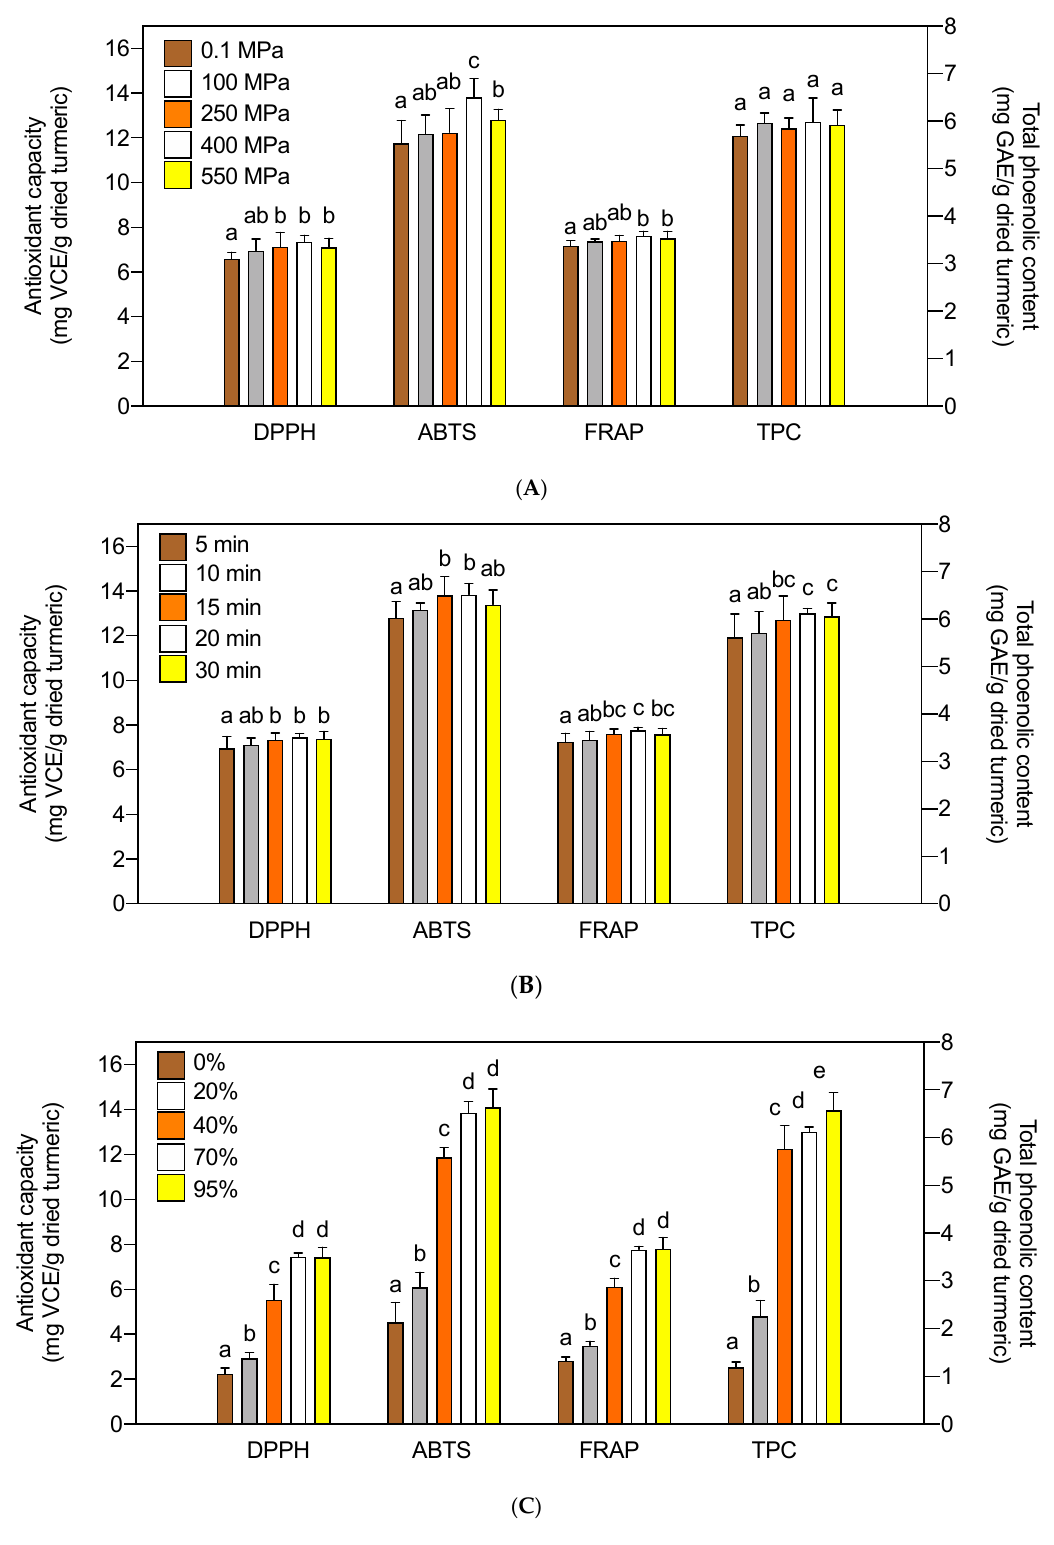
Figure 1. Effects of pressure ( A ), extraction time ( B ), and ethanol concentration ( C ) on antioxidant activities and total phenolic contents (TPC) of the HHPE turmeric. Same letters in each group indicates that they are not statistically different at p < 0.05.